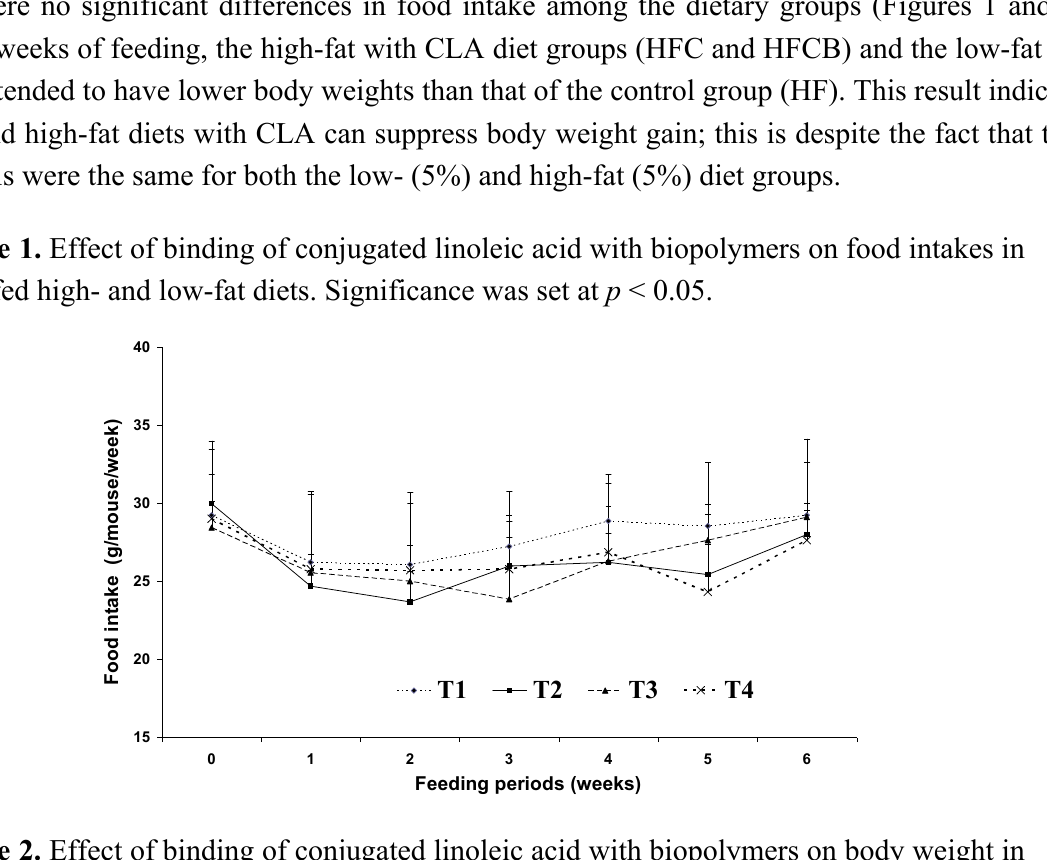
Figure 2. Effect of binding of conjugated linoleic acid with biopolymers on body weight in mice fed high- and low-fat diets. Significance was set at p <